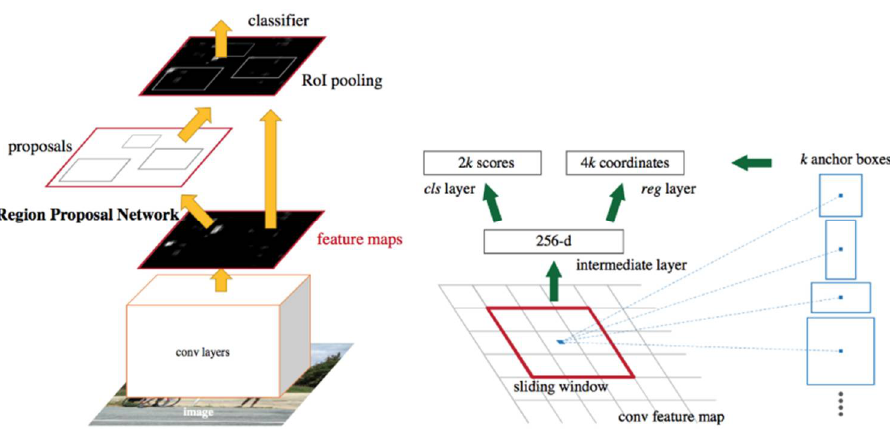
Figure 2. Faster R-CNN structure. R-CNN: Regions with convolutional neural network